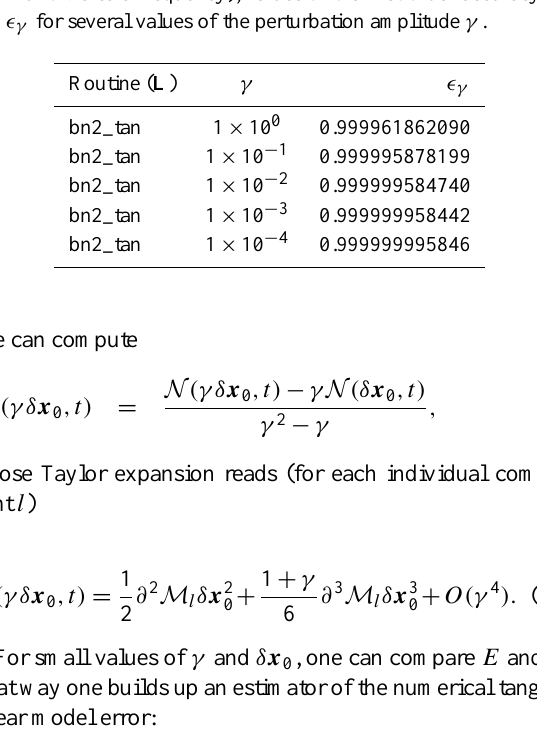
Table 2. Approximation error in the tangent linear model for differ- ent configurations over 10